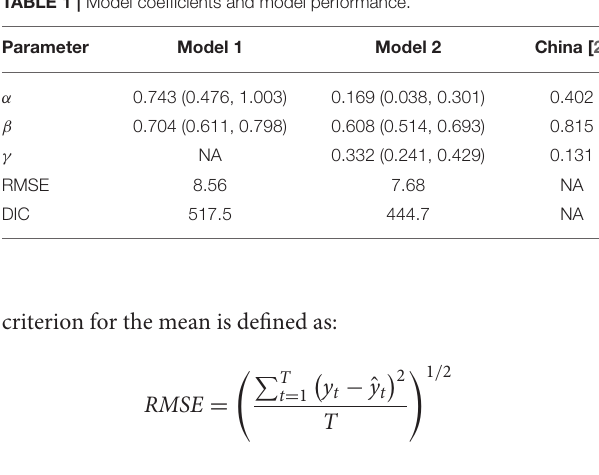
TABLE 1 | Model coefficients and model